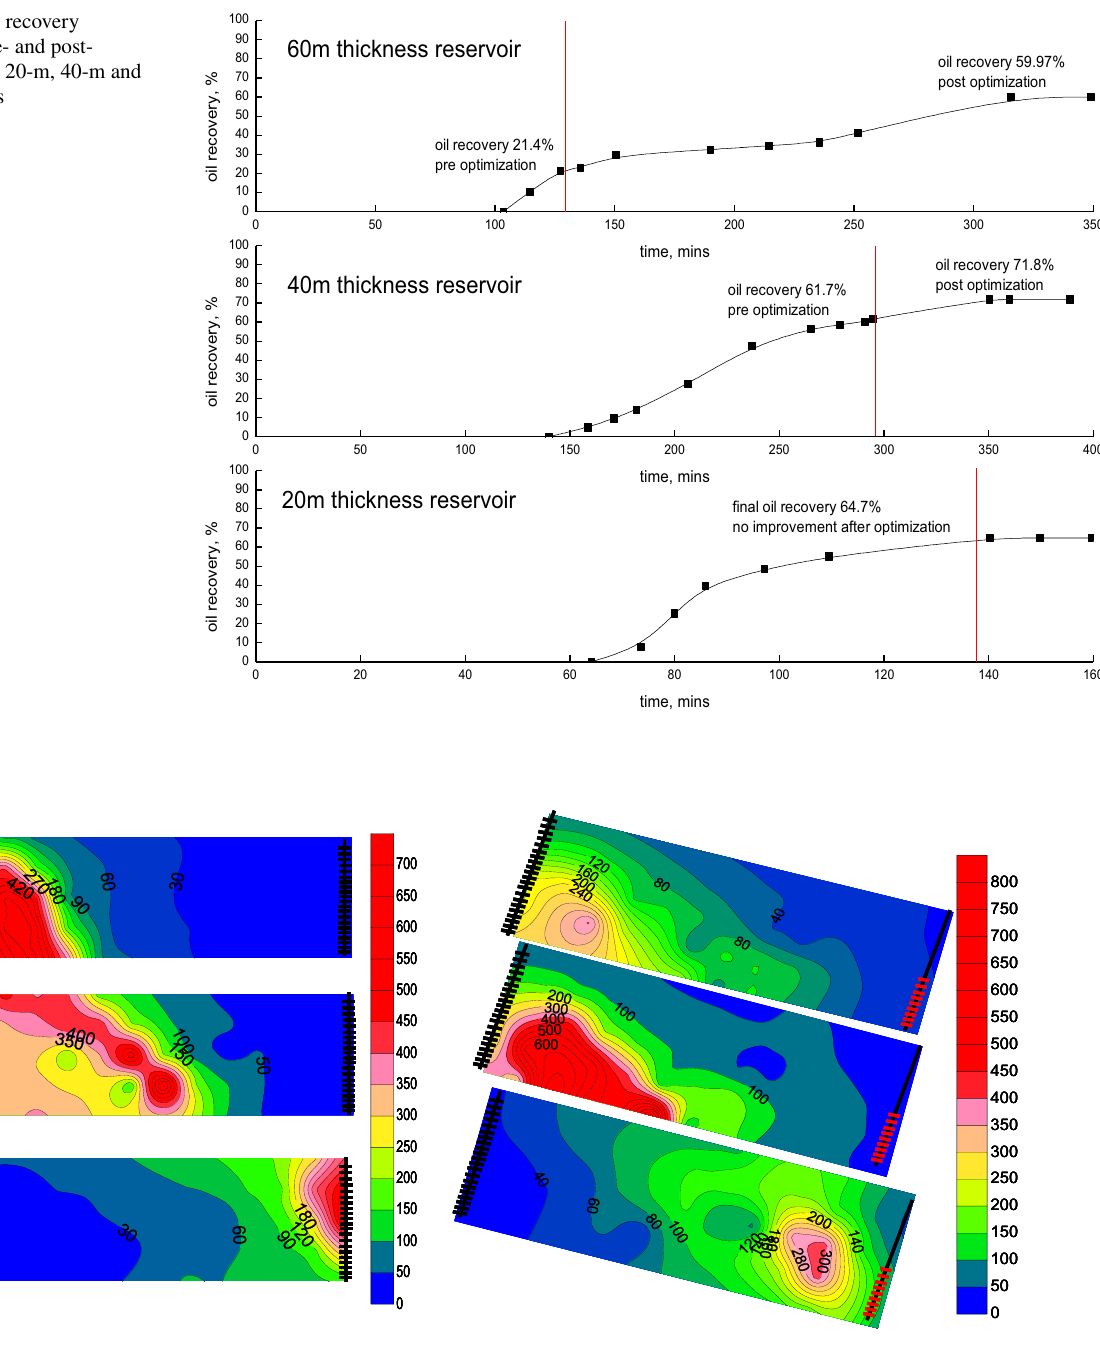
Fig. 11 The combustion front propagation in 40-m reservoir of different structural dip (0° and